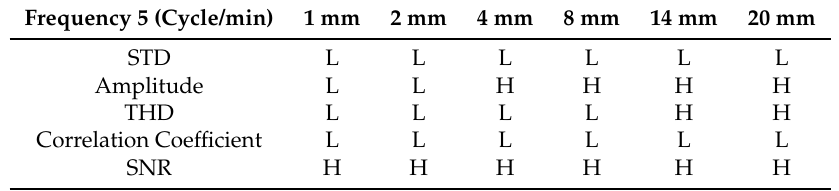
Table A6. Values higher and lower than the median for Frequency of 5 cycles/min for a 3 mm band.